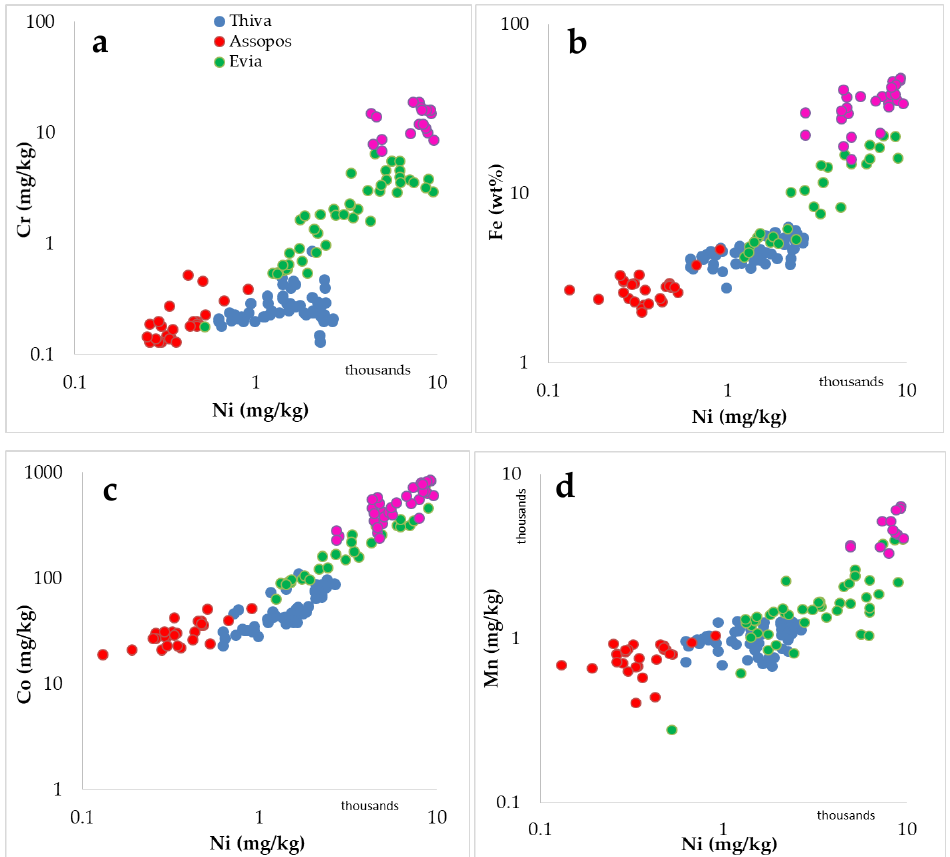
Figure 2. Variation of ( a ) Cr, ( b ) Fe, ( c ) Co, and ( d ) Mn versus Ni contents in soils from the Assopos–Thiva basins, C. Evia., and, in laterite deposits. Data from [50,60–63].